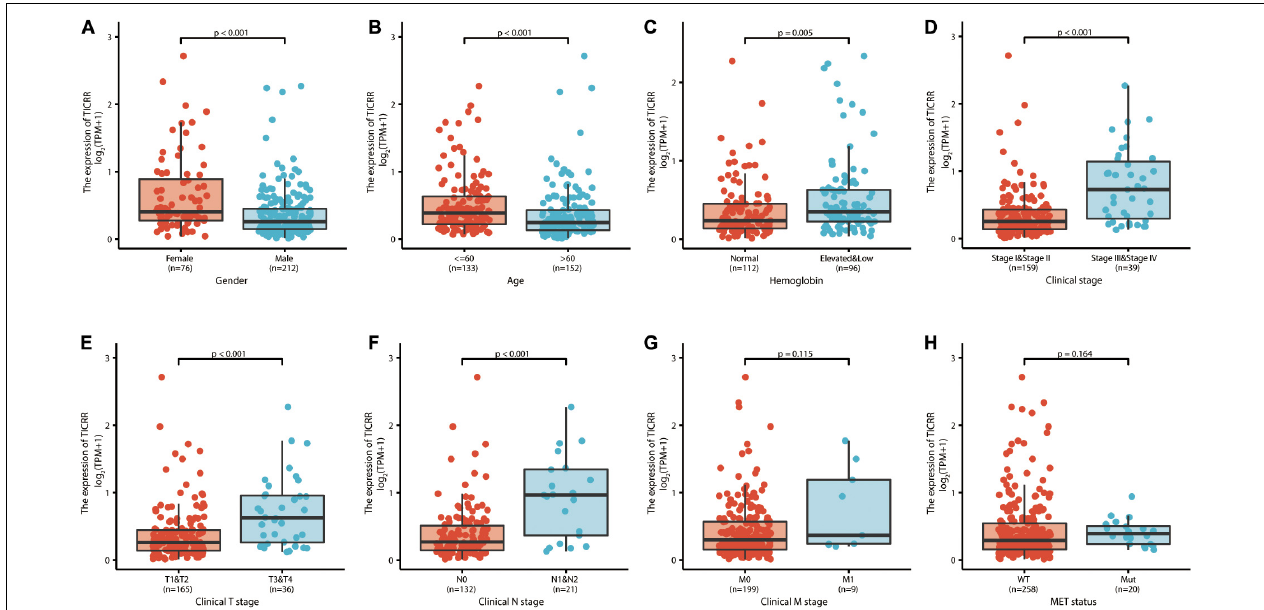
FIGURE 4 | TICRR expression is associated with clinicopathological characteristics in papillary renal cell carcinoma (PRCC) patients. The Wilcoxon rank sum test was applied to analyze the association of TICRR expression with sex (A) , age (B) , hemoglobin level (C) , clinical stage (D) , clinical T stage (E) , clinical N stage (F) , clinical M stage (G) , and MET status (H) .